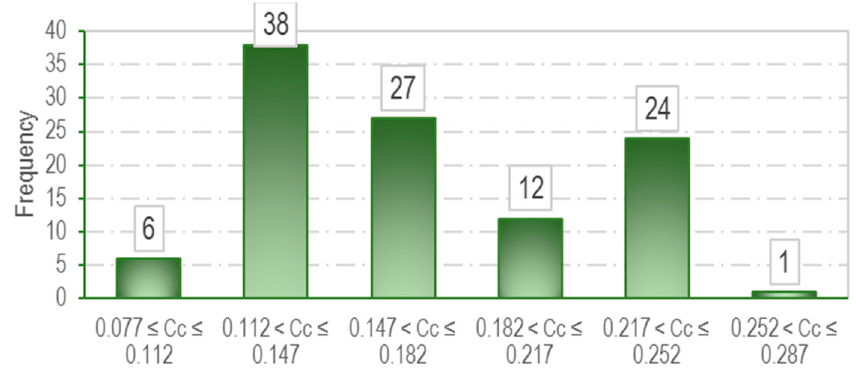
Figure 5. Distribution of C c .